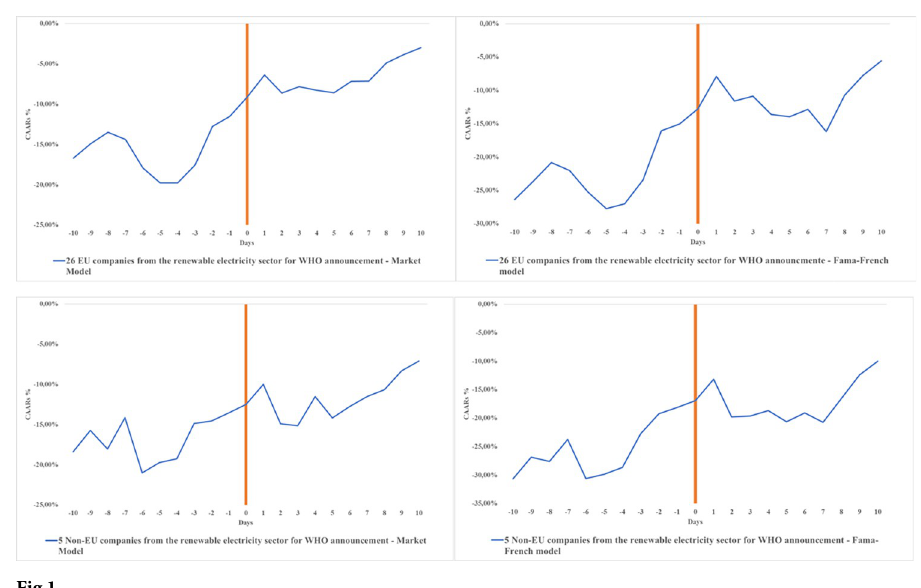
Fig 1. To test hypothesis H2a, we compare the results for EU companies in Panel A with Panel C for the WHO announcement. The significant negative impact of COVID-19 was larger for EU renewable electricity companies, since investing in this alternative way of producing electricity is considered riskier than investing in traditional electricity [47]. For national lockdowns in the EU, we compare Panel B with Panel D, with mostly similar results. Therefore, hypothesis H2a is supported. To test hypothesis H2b for European electricity companies outside the EU, we compare Panel A with Panel C, and Panel B with Panel D, for the WHO announcement and national lockdowns, respectively. As with hypothesis H2a, the results support hypothesis